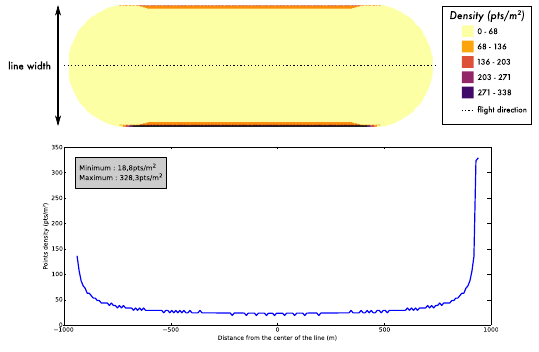
Figure 10. Theoretical Leica SPL100 point density map (top) and swath cross-section (bottom).